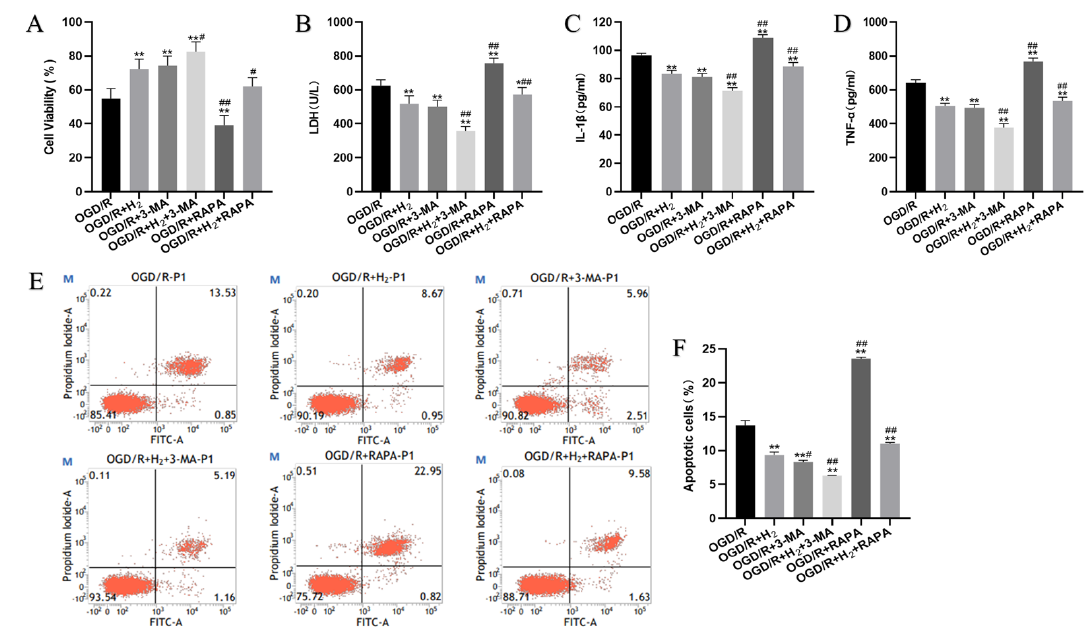
Figure 4. H 2 pro tected HT22 cells from OGD/R injury by inhibiting autophagy. ( A ) The neuronal viability of HT22 cells per group. ( B ) The release of LDH in each group. ( C ) The IL1−β level in the medium. ( D ) The TNF−α level in the medium. ( E ) Images of HT22 cell analysis by flow cytometry as depicted by dot plots. ( F ) Quantification of the cellular apoptotic rates via flow cytometry. A minimum of three separate repetitions of the experiments produced similar findings. * p < 0.05, ** p < 0.01 vs. OGD/R group. # p < 0.05, ## p < 0.01 vs. OGD/R+H 2 group.